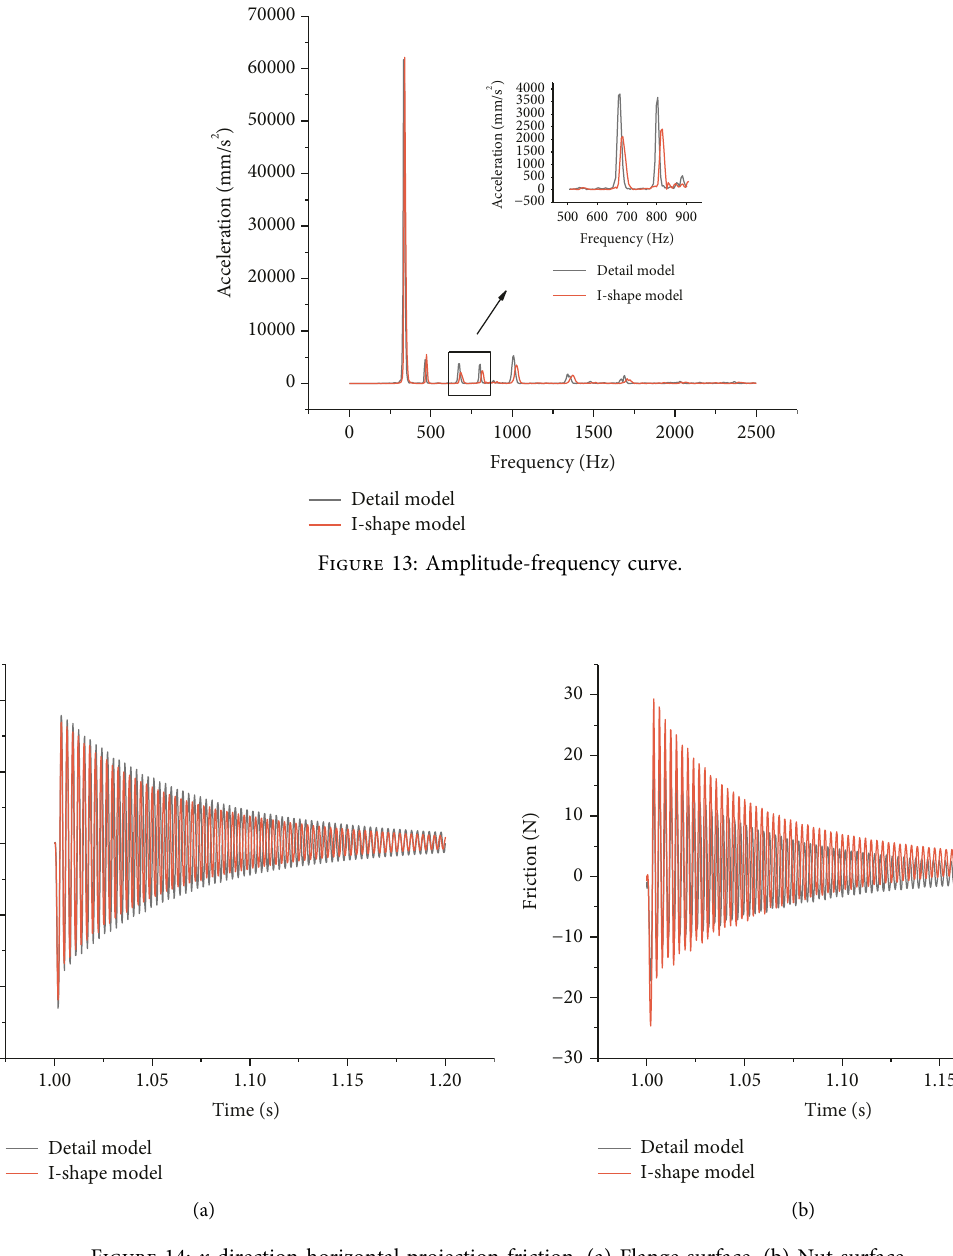
Figure 14: x -direction horizontal projection friction. (a) Flange surface. (b) Nut